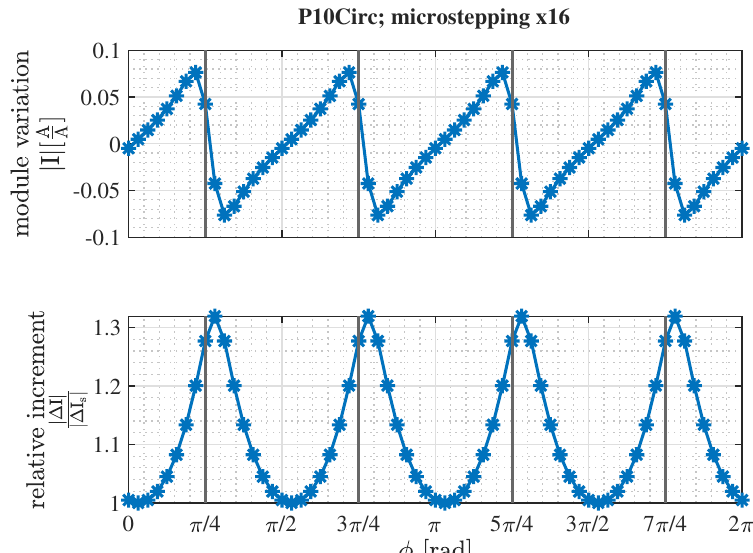
Figure 9. Torque variation and increment relative to a sine-cosine microstepping of equal resolution; p = 10 microstepping resolution x16.